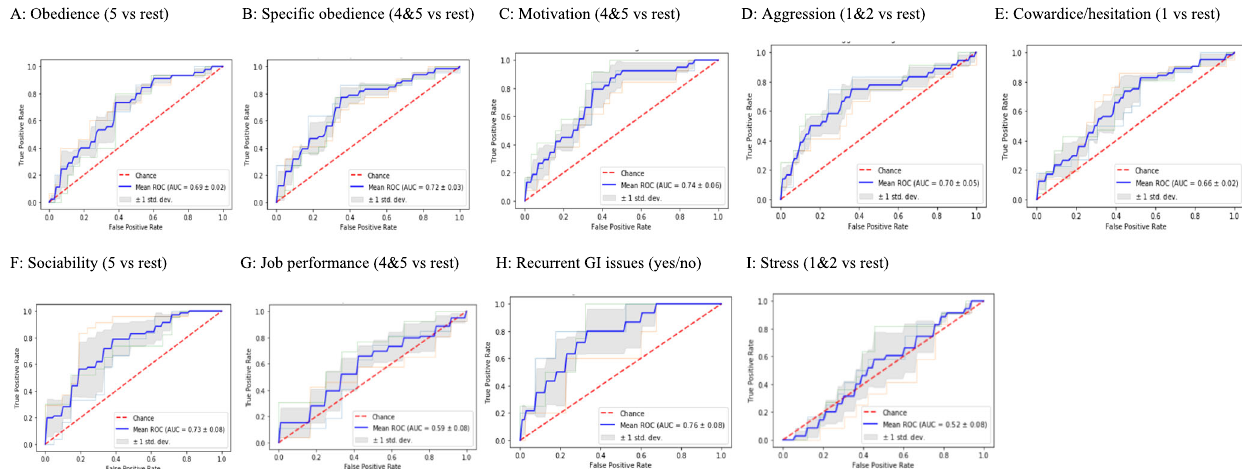
Fig. 9 Association of phenotypic working canine characteristics with microbiome features. Classi fi cation of phenotypic characteristics was based on working canine microbiome characteristics including obedience ( A ), obedience to one trainer vs many trainers (speci fi city, B ), motivation ( C ), aggression ( D ), cowardice/hesitation ( E ), sociability ( F ), job performance ( G ), recurrent gastrointestinal (GI) issues ( H ), and stress level ( I